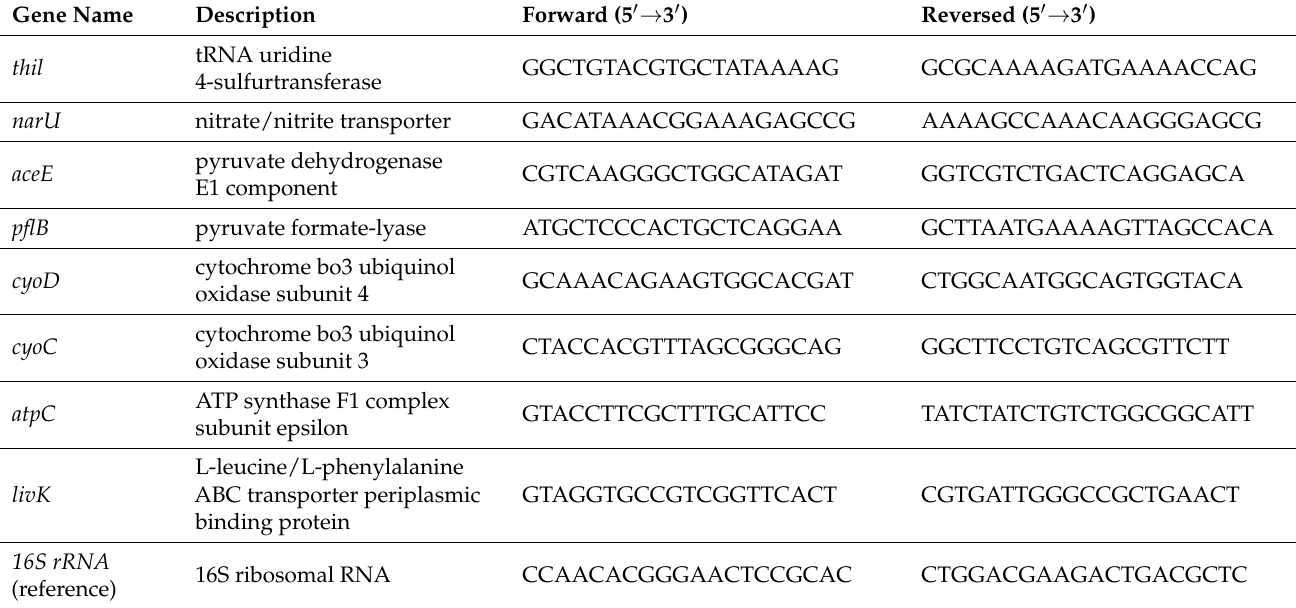
Table 1. Primers used in